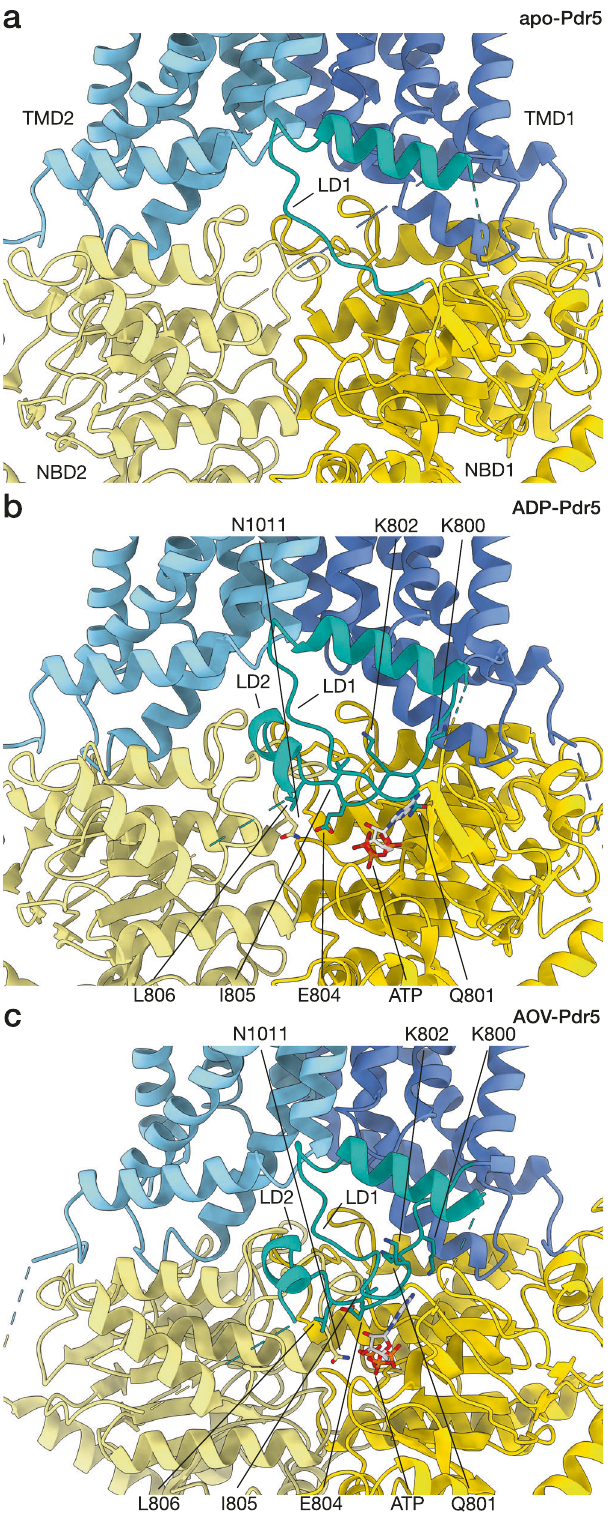
Fig. 3 Structure of Pdr5 linker domain. Section of the Pdr5 structure surrounding the linker domain is shown in cartoon representation. ATP in the non-hydrolytic site and some of the conserved residues of the linker domain are depicted in stick representation. The three panels represent different states of Pdr5: ( a ) the inward-facing apo-Pdr5, ( b ) the